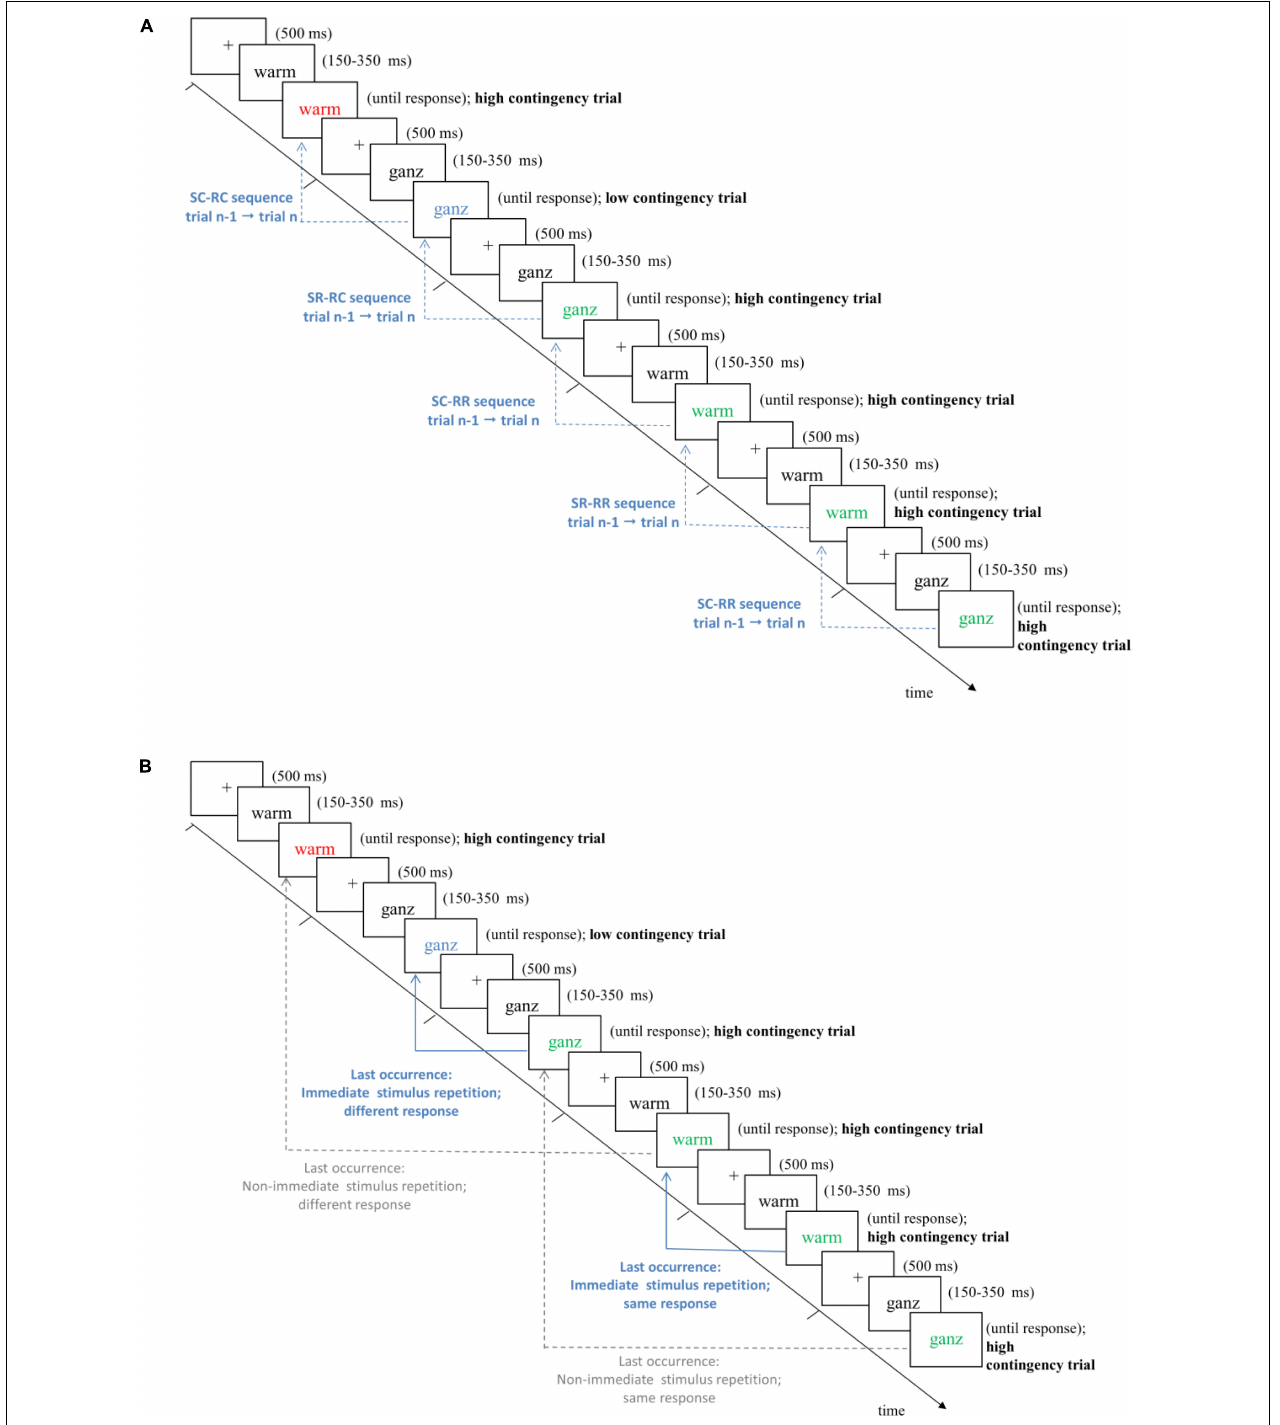
FIGURE 1 | Schematic trial procedure in Experiments 1 and 2. Note that in the experiments, all stimuli were presented on black background in white font or in the respective colors (see Table 1 ). For both figures, we inverted the coloring scheme only for illustrative purposes. Stimuli are not drawn to scale. Trials are classified as high vs. low contingency trials (for details, see Table 1 ). Arrows in (A) illustrate different trial types for immediate sequence effects from trial n-1 to trial n to test for immediate SRBR effects (SR, stimulus repetition; SC, stimulus change; RR, response repetition; RC, response change). Arrows in (B) illustrate trial classification for the central analyses of interest to explain contingency learning effects by response retrieval effects, i.e., whether a given trial reflected an immediate (solid/blue lines) vs. non-immediate (dotted/gray lines) stimulus repetition trial (factor Distance) with same or different response (factor Previous Response) compared to the last occurrence of the stimulus word. See main text for